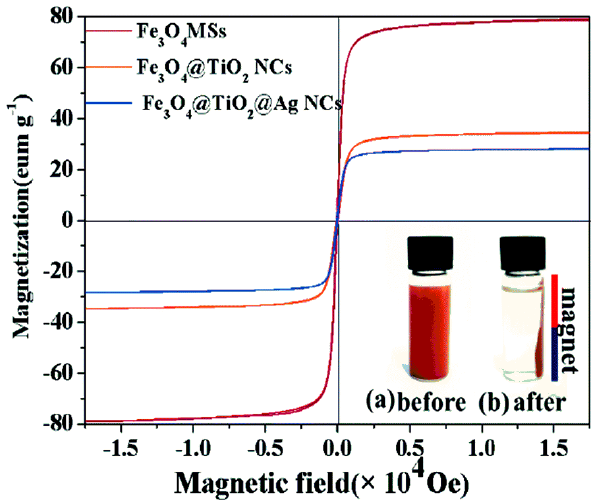
Figure 4. Magnetization curves and insert showing magnetic separation of Fe 3 O 4 /TiO 2 /Ag. Reproduced with permission from [116]. Copyright 2016, RSC.